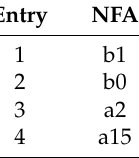
Table 7. Synthetic complexities and relevant parameters for a series of NFAs described in this review. Entry NFA NSS SC Cost (EUR / g) 1 b1